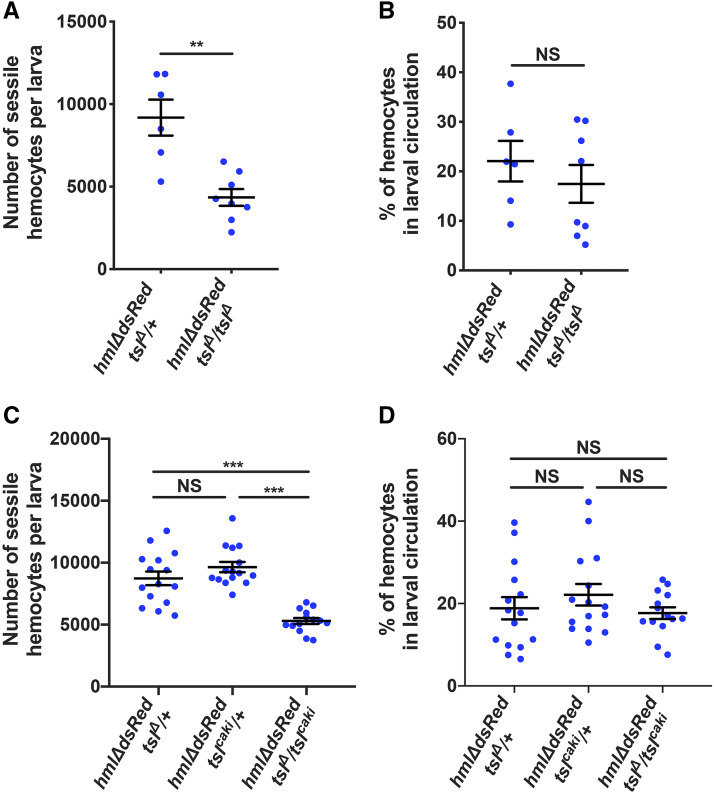
Tsl is required for both sessile and circulating larval hemocyte populations. (A) Quantification of sessile hemocyte numbers (hmlΔ-dsRed) in wandering tslΔ/tslΔ and tslΔ/+ larvae. tslΔ/tslΔ larvae have significantly fewer sessile hemocytes than tslΔ/+ controls (P = 0.003). (B) No significant difference in the proportion of hemocytes in circulation was observed between wandering tslΔ/tslΔ mutant and tslΔ/+ control larvae (P = 0.573). (C) Quantification of sessile hemocyte numbers (hmlΔ-dsRed) in wandering tslΔ/+, tslcaki/+ and tslΔ/tslcaki larvae. tslcaki/tslΔ transheterozygote larvae have significantly fewer sessile hemocytes than both heterozygous controls (P < 0.001). (D) No significant difference in the proportion of hemocytes in circulation was observed between wandering tslΔ/tslcaki larvae and either tslΔ/+ (P = 0.915) or tslcaki/+ controls (P = 0.451). NS, not significant, *P < 0.05, **P < 0.01, ***P < 0.001, Mann-Whitney test. Data points are individual larvae with the mean ± 1 SE indicated (n ≥ 6).